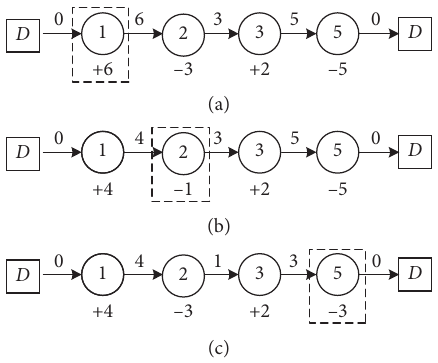
Figure 9: Feasible solutions after applying repair operator. (a) Adjustment of the loading quantities of station 1. (b) Adjustment of the unloading quantities of station 2. (c) Adjustment of the unloading quantities of station 5.